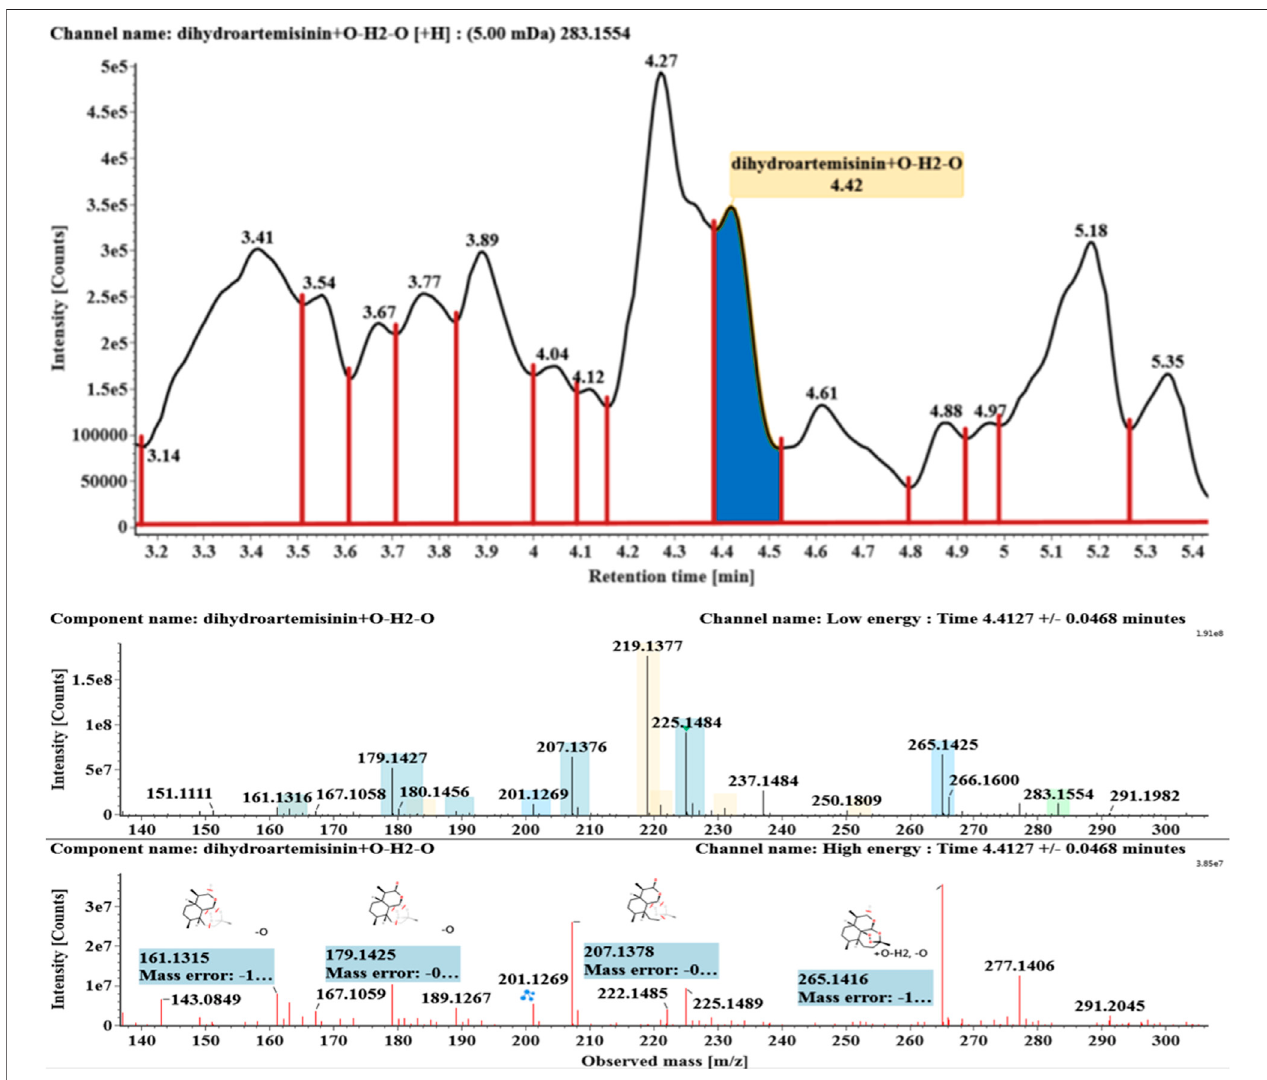
FIGURE 8 | Extracted ion chromatograms and mass spectrometry (MS E ) spectra of M7 .